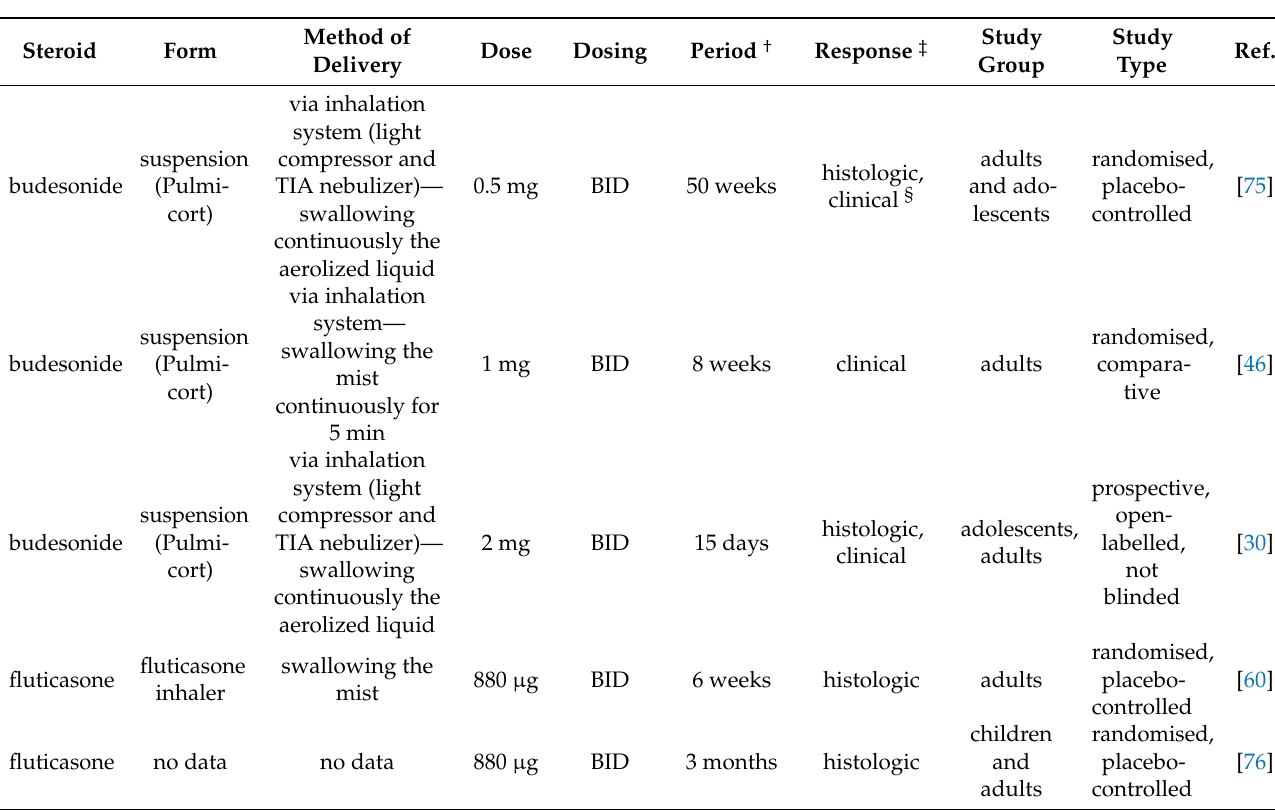
Table 4. Overview of aerolised topical steroids used in EoE in randomised controlled trials (RCT) and retrospective